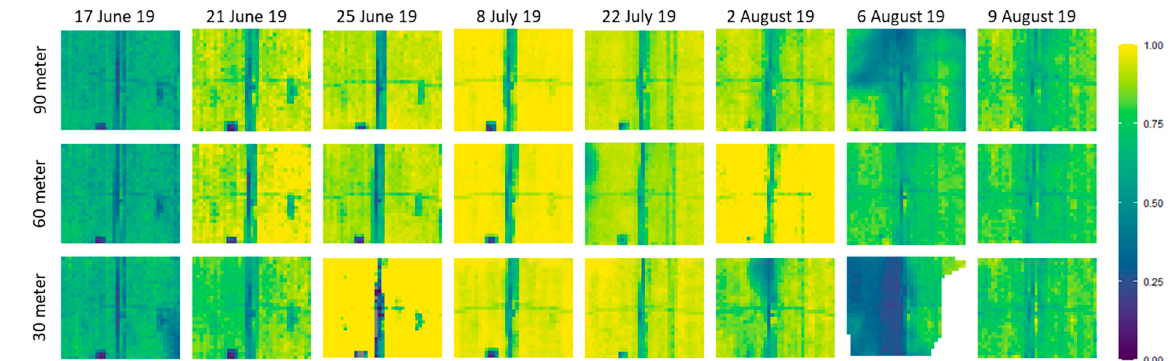
Figure A2. Enhanced Vegetation Index (EVI, unitless) raster maps for each mission. Maps are linearly scaled to the same color bar.